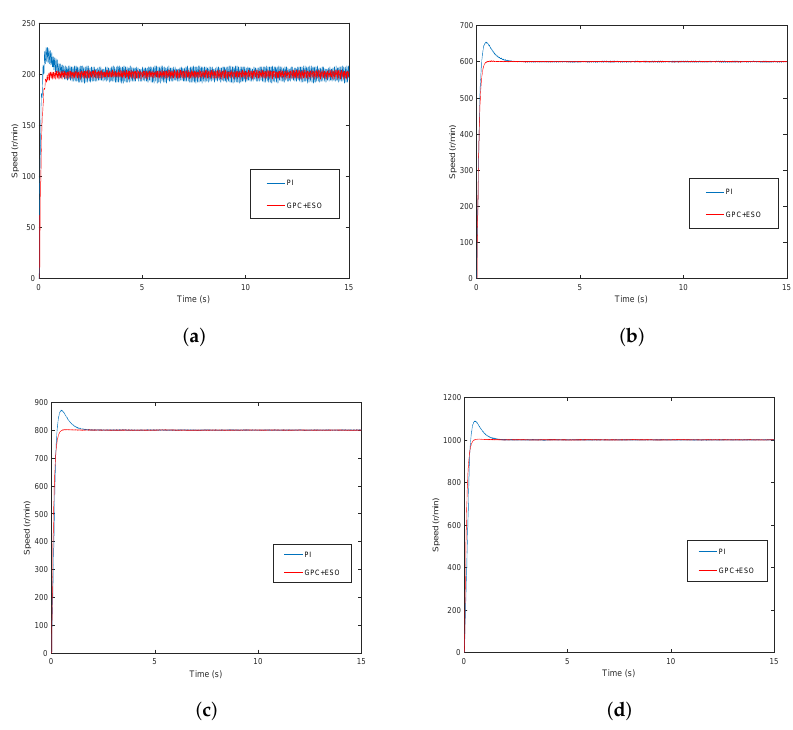
Figure 7. Experimental speed curves under the GPC+ESO and PI method. ( a ) n = 200 r/min; ( b ) n = 600 r/min; ( c ) n = 800 r/min; and ( d ) n = 1000 r/min.